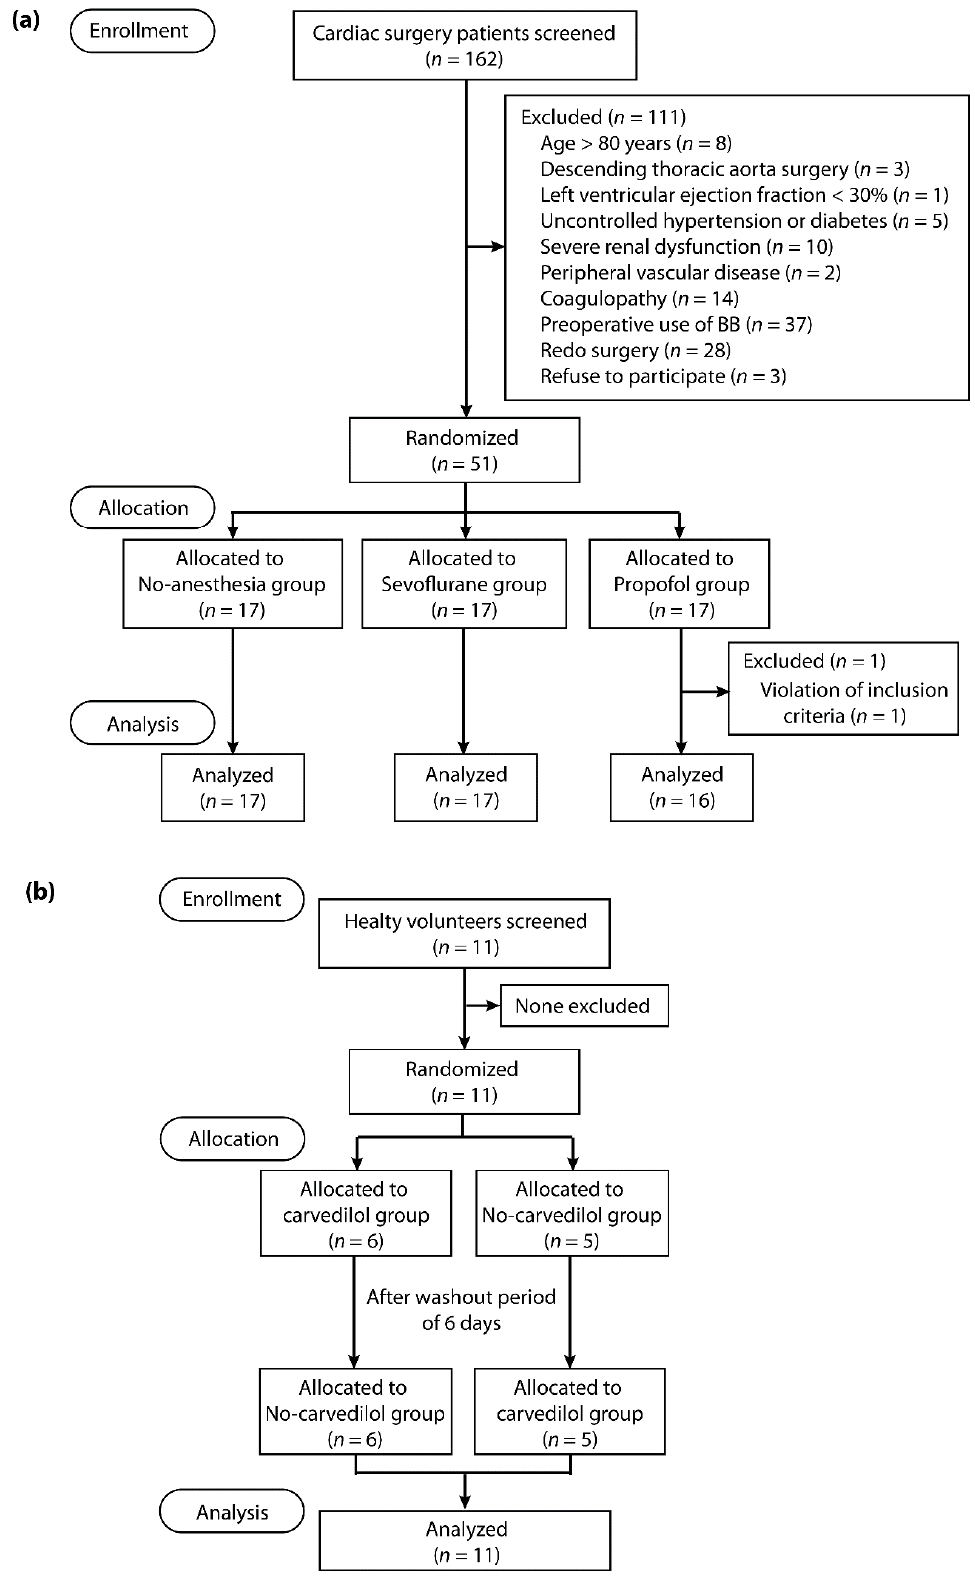
Figure 1. Study flow diagram of: ( a ) cardiac surgery patients; and ( b ) healthy volunteers. Eleven healthy volunteers were recruited between 17 May 2017 and 25 October 2017 and completed the protocol (Figure 1b). No complications related to RIPC or the use of carvedilol